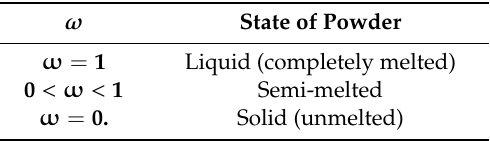
Table 4. State of AZ91D magnesium powder represented by ω .